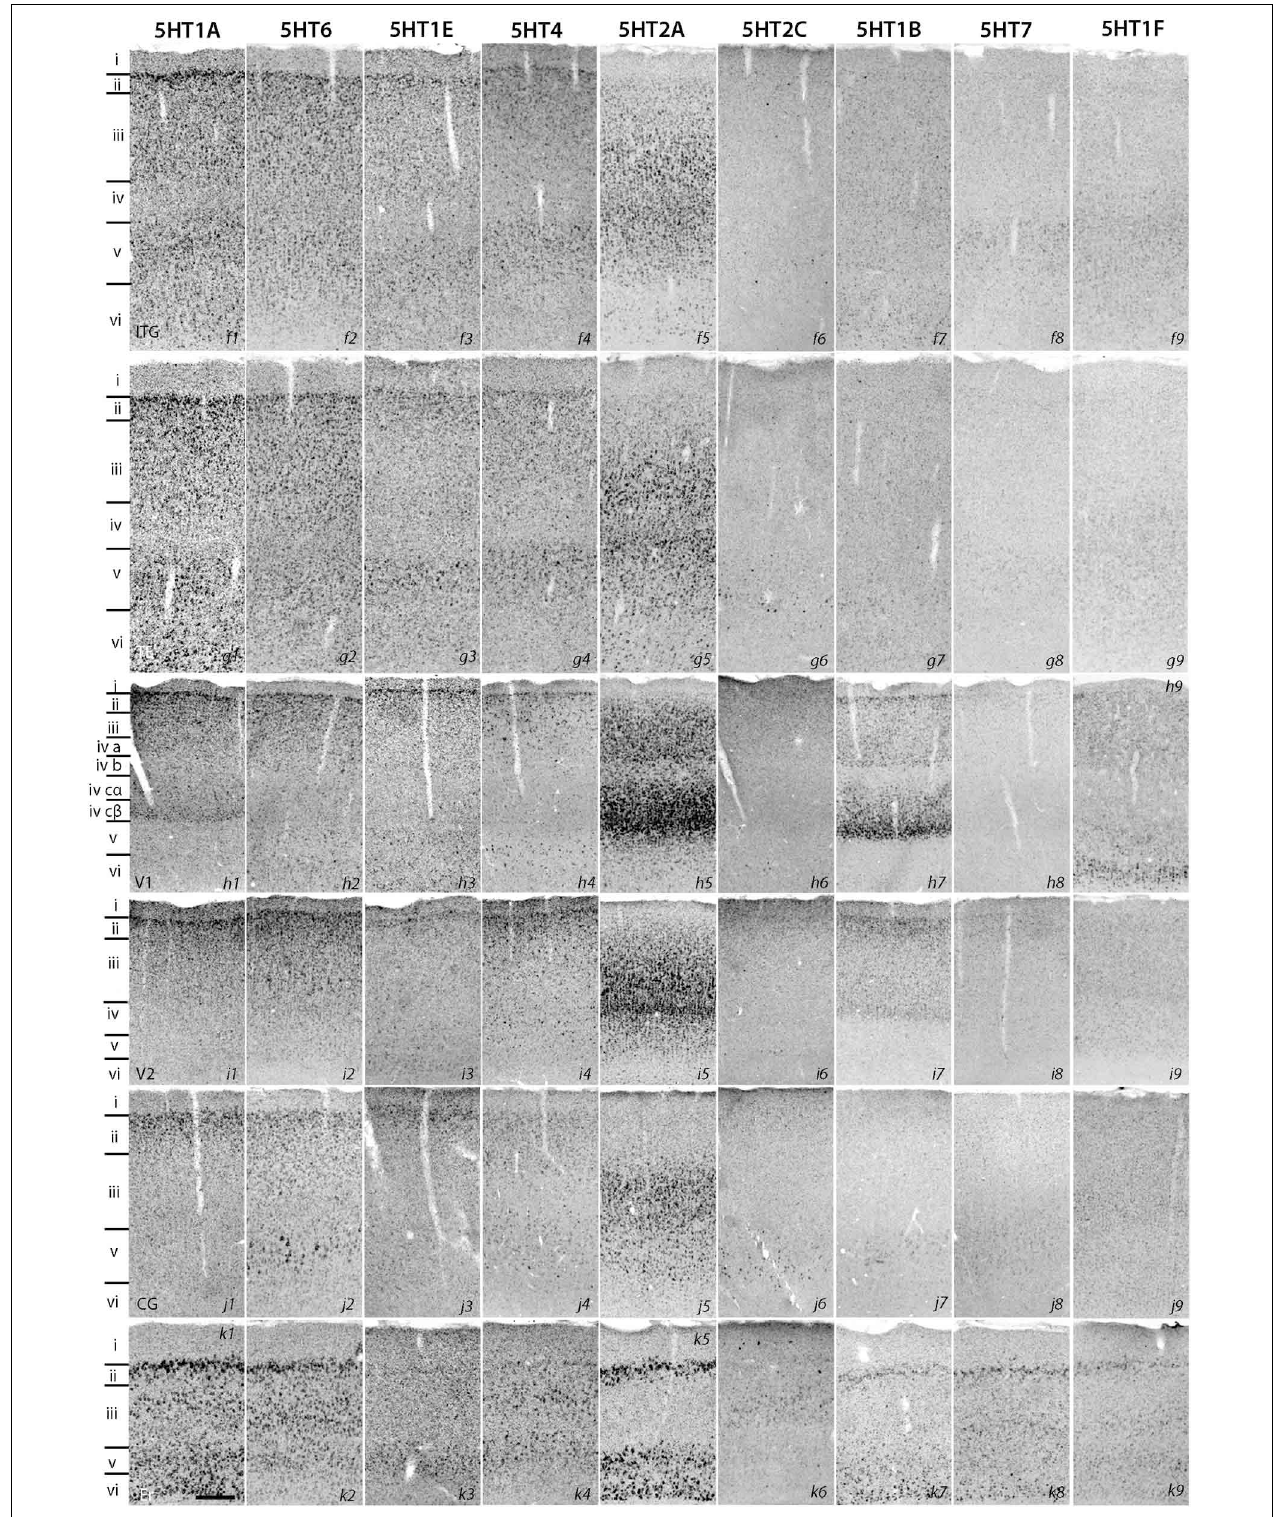
FIGURE 2 | ISH expression profiles of 5HTRs in cortex. Inferotemporal gyrus (ITG), temporal cortex (TE), primary visual cortex (V1), secondary visual cortex (V2), cingulate cortex (CG), and entorhinal cortex (Er).